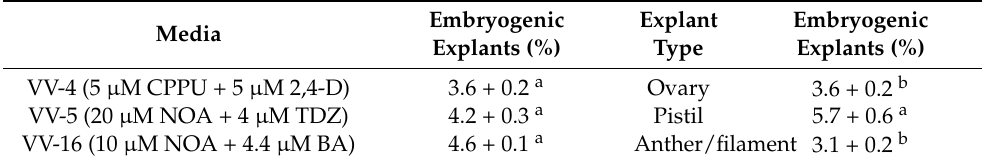
Table 4. Effect of three PGR combinations (VV-4, VV-5, and VV-16) and three explant types (ovary, pistil, and anther/filament) on somatic